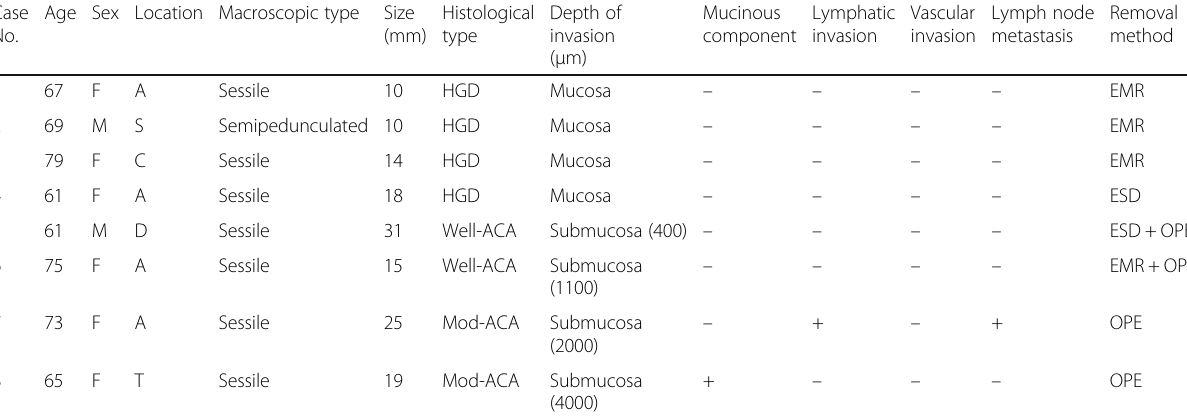
Table 1 Summary of clinicopathological features in each case of sessile serrated adenoma/polyp (SSA/P) with dysplasia and invasive adenocarcinoma Case